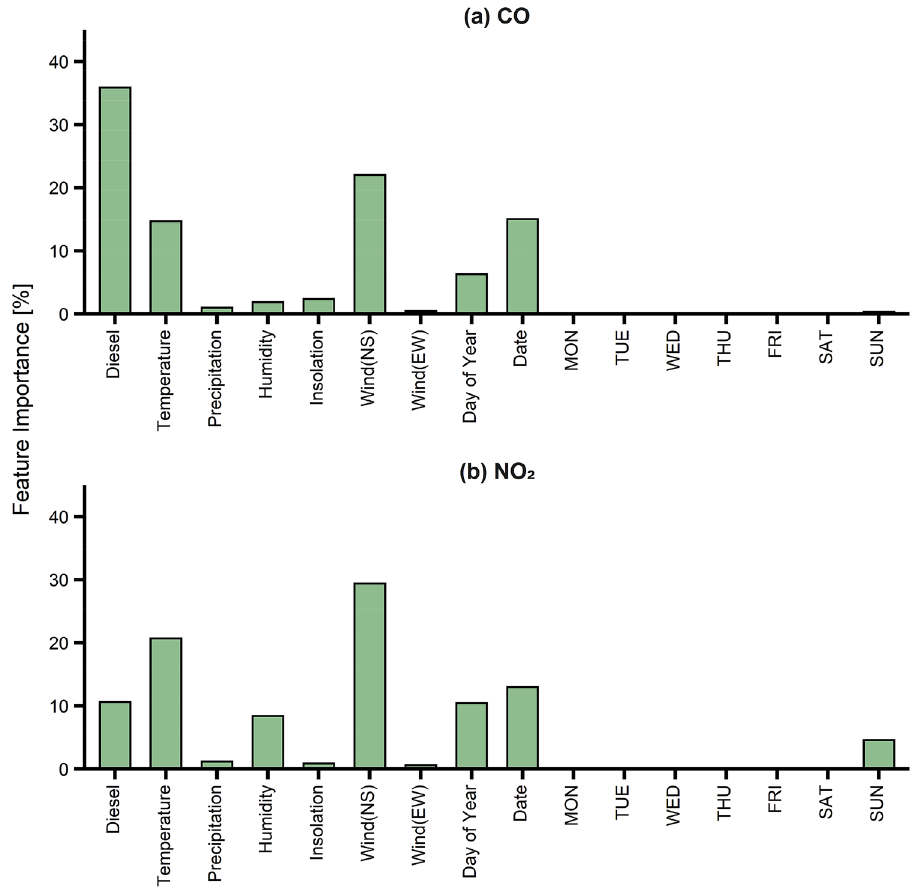
Figure 1. Feature importance of ( a ) CO and ( b ) NO 2